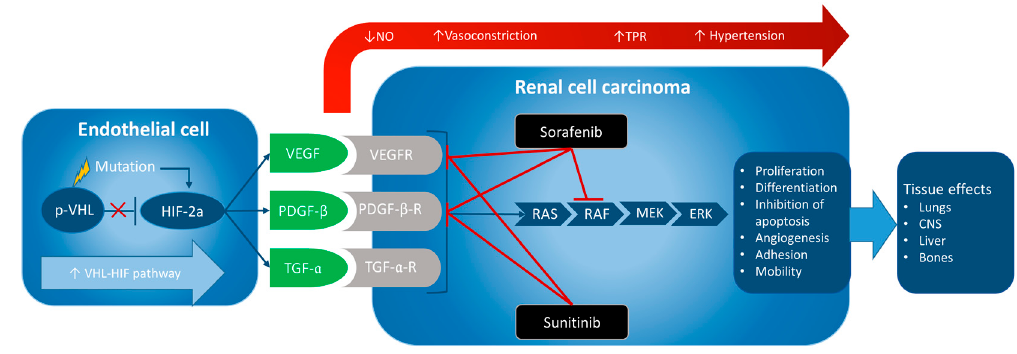
Figure 1. Mutation in the von Hippel–Lindau gene ( VHL ) induces loss (red ×: HIF-2a is no longer inhibited) of the regulatory tumour suppressor p -VHL and catalyses the “von Hippel– Lindau-hypoxia-inducible factor” VHL-HIF pathway. Increased expression of transcription factor HIF-2 α causes (blue arrows) higher levels of growth factors (GFs) VEGF, PDGF- β and TGF- α . Sorafenib and sunitinib block their receptors (in red TKI effects), and the intracellular Ras/Raf/MEK/ERK cascade (sorafenib) thereby inhibiting tumorigenesis and metastasis. Inhibition of GFs leads to a decrease in NO-production and reduced endothelial permeability, resulting in increased vasoconstriction, total peripheral resistance (TPR), and hypertension (red